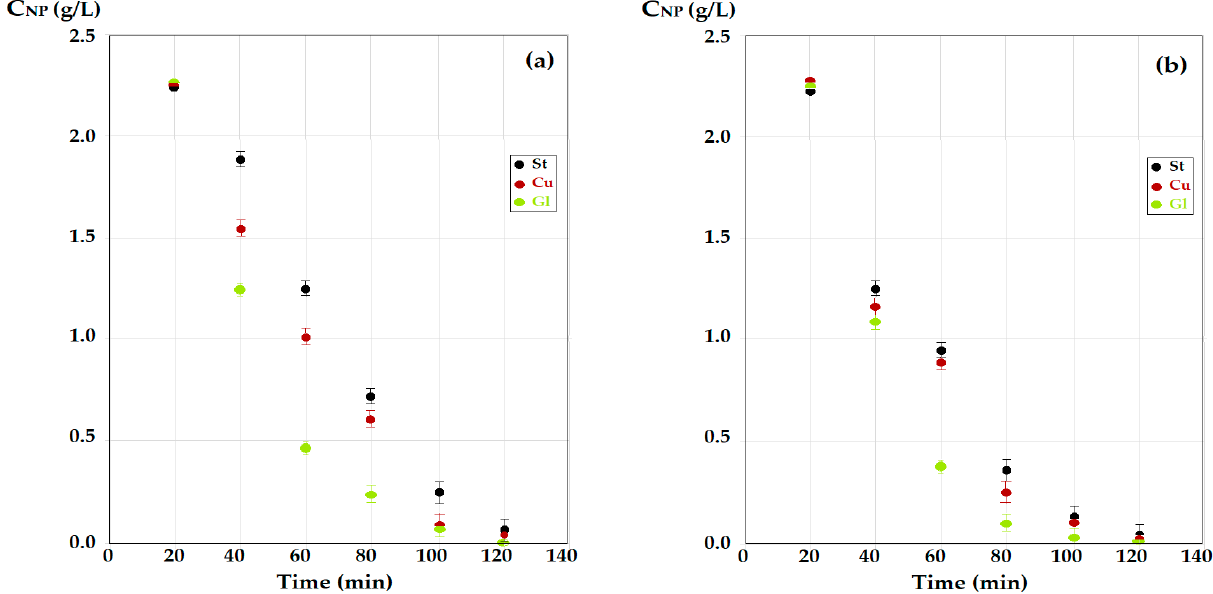
Figure 5. The decrease in concentration of p –nitrophenol for operation with the three types of materials: St, steel; Cu, copper; and Gl, glass; ( a ) for source phase with pH = 5; ( b ) with pH = 2; at the same value of the pH of receiving phase (pH = 13), for n –octanol membrane.